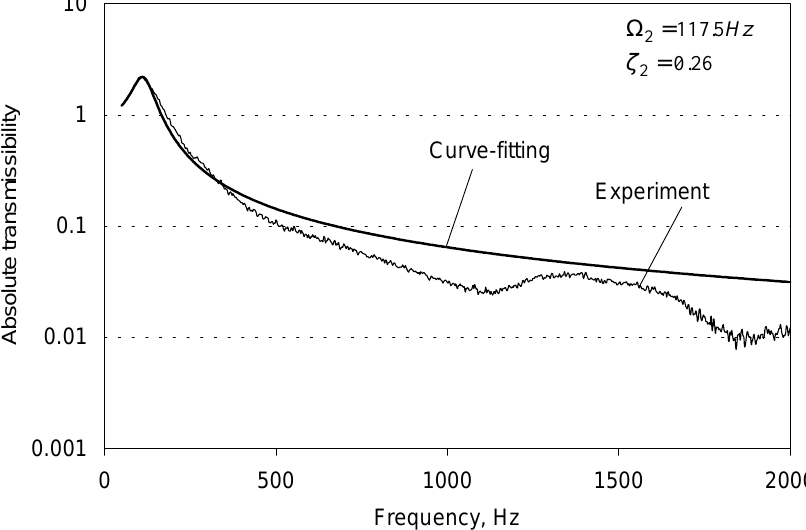
Fig.16. Experimentallymeasuredabsolutetransmissibilityoftheprimaryvibrationisolatorandestimationofitsmodalparametersbycurve-fitting.